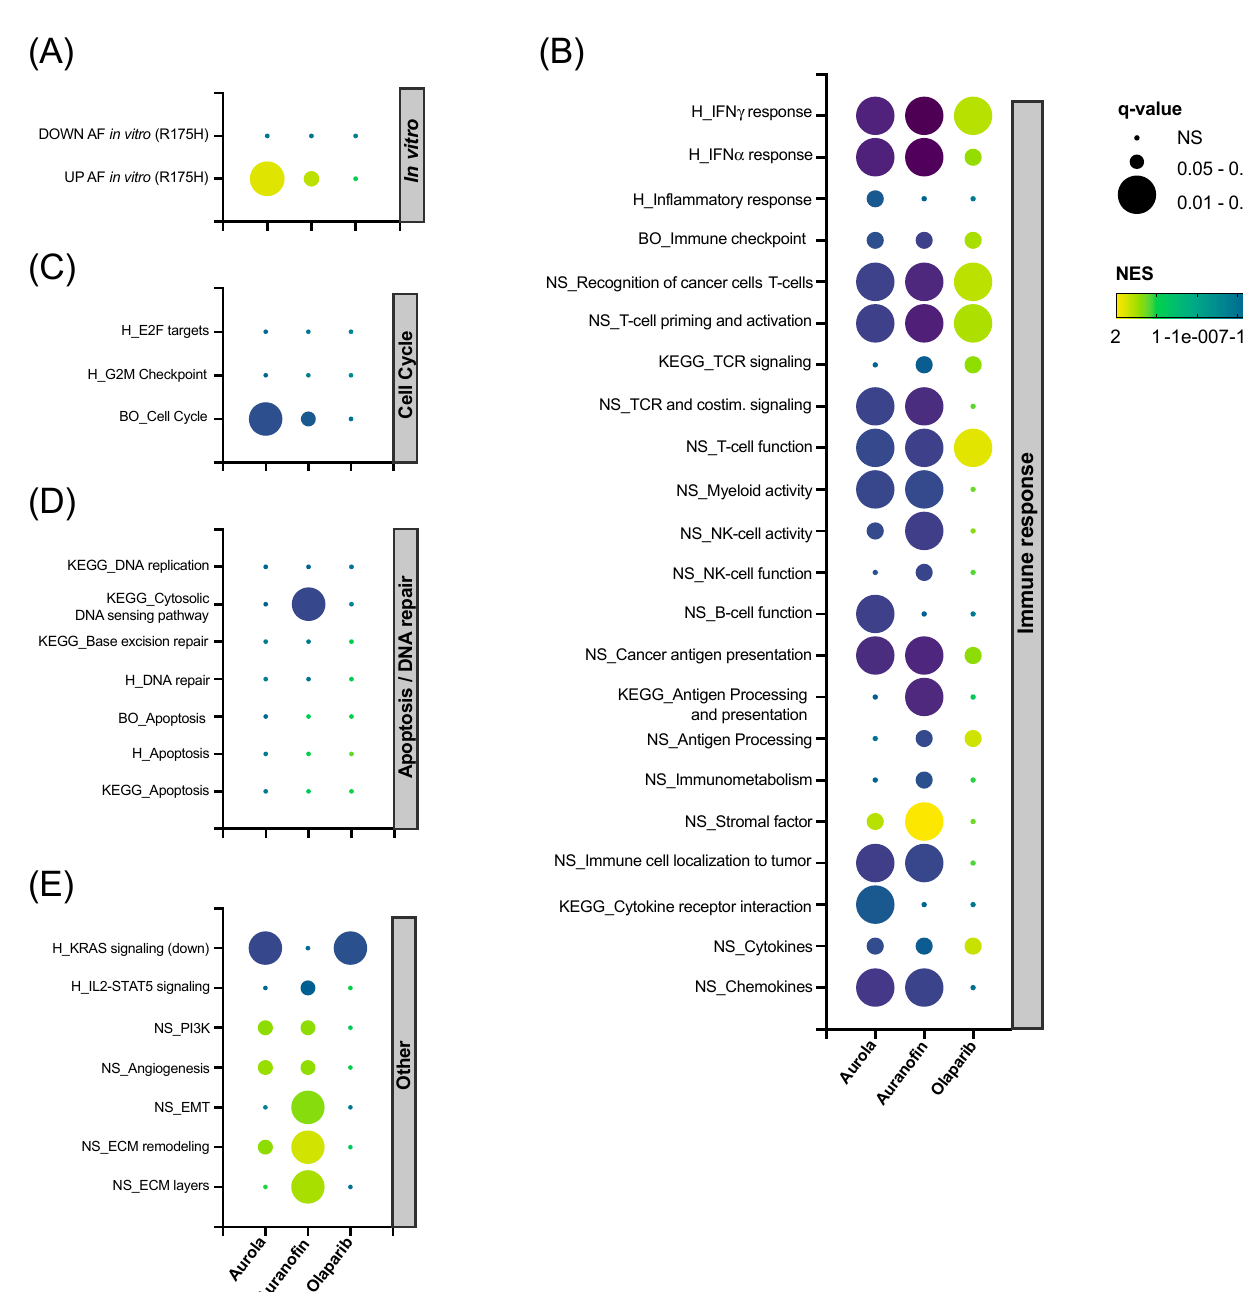
gavage administered for 14 consecutive days) with red arrows. ( B ) Tumor growth kinetics until day 13 after different treatments as indicated ( n = 12–14 mice per group). Error bars represent the standard error of the mean. ( C ) Tumor growth kinetics over time ( n = 6–8 mice per group) after different treatments as indicated. Error bars represent the standard deviation. ( D – F ) Spaghetti plots of tumor volumes for individual mice in each treatment group (solid lines) compared to individual mice in vehicle group (dotted lines). ( G ) Survival of 129-mice ( n = 6–8 mice per group) after different treatments as indicated. * p ≤ 0.05; *** p ≤ 0.001.